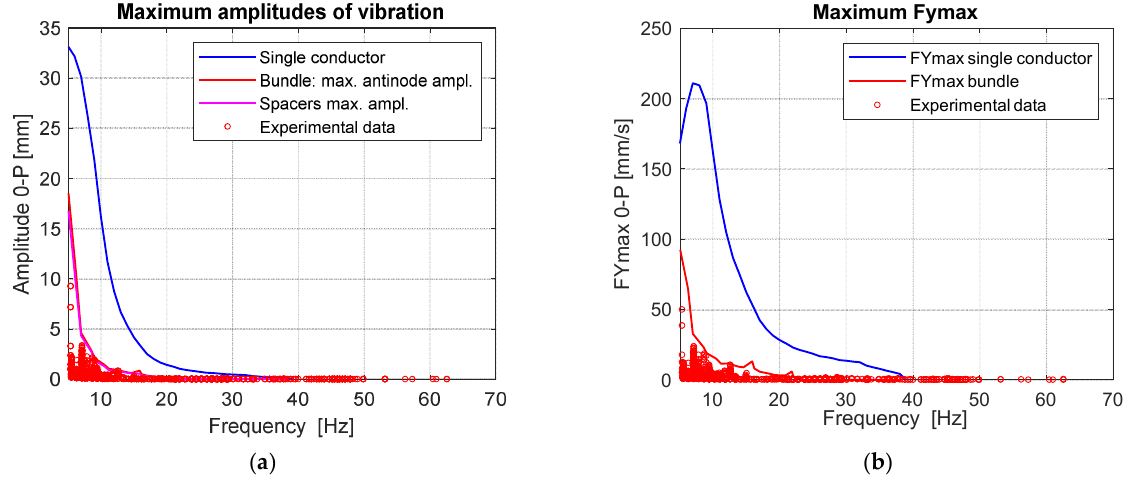
Figure 23. Comparison between experimental and numerical results: ( a ) Maximum antinode amplitudes as function of vibration frequency; ( b ) Maximum fy max as function of vibration frequency.